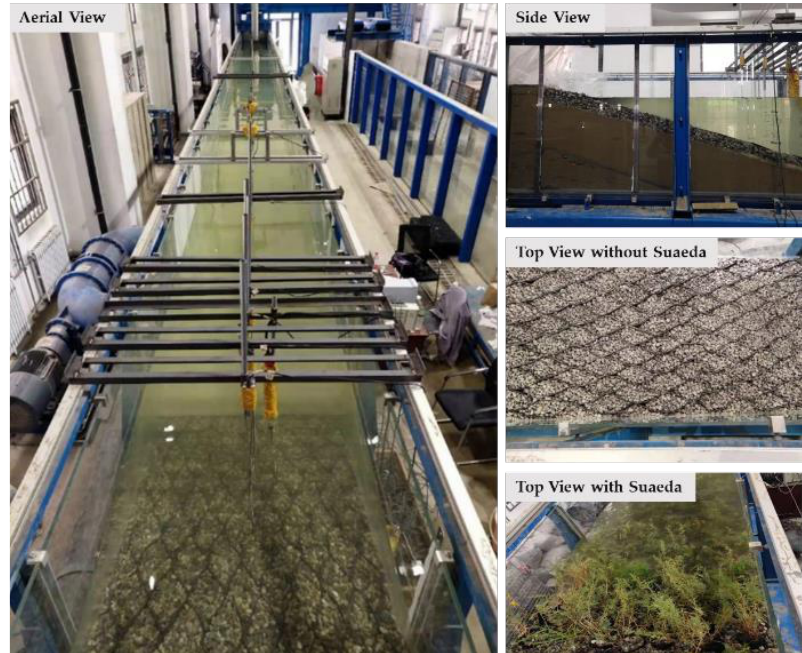
Figure 1. Experimental section with Suaeda.